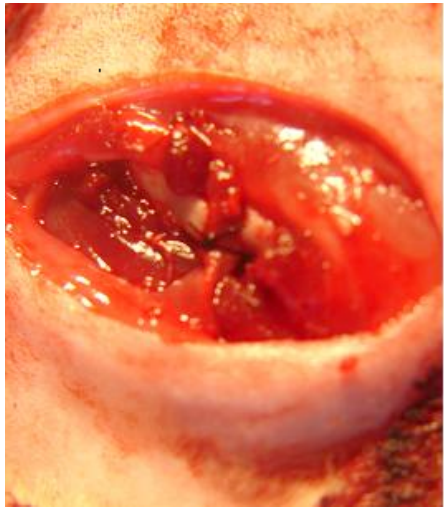
FIGURE 2 - Fascia lata flap (arrow) inserted between the segments of the